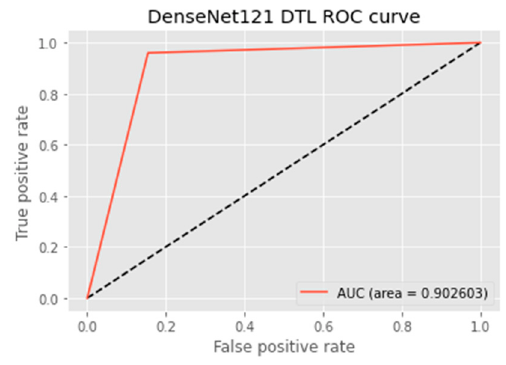
Figure 13. ROC curve of the DenseNet121 model .